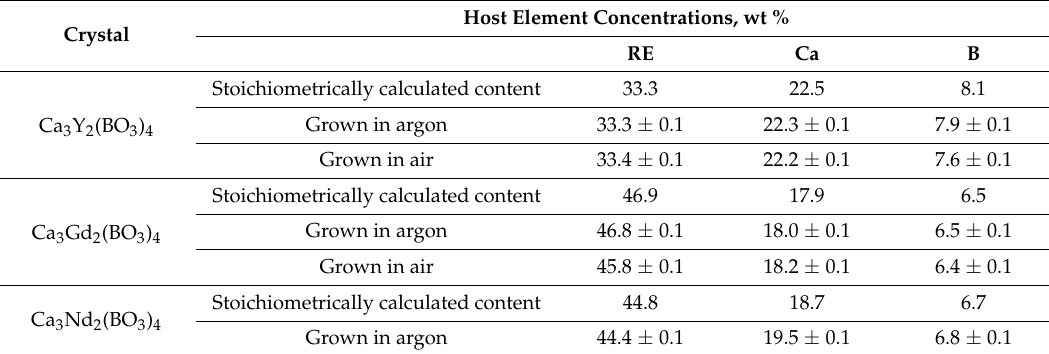
Table 2. Concentrations of host elements for Ca 3 RE 2 (BO 3 ) 4 (RE = Y, Gd, Nd) crystals.